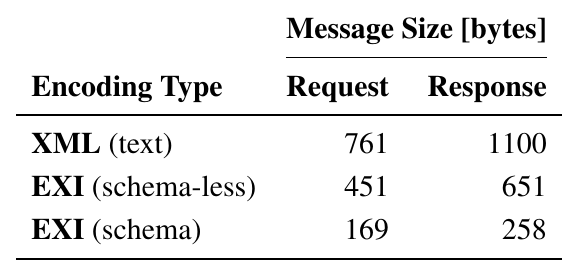
Table 1. Size of the request and response messages for plain XML, EXI schema-less and EXI schema-enabled